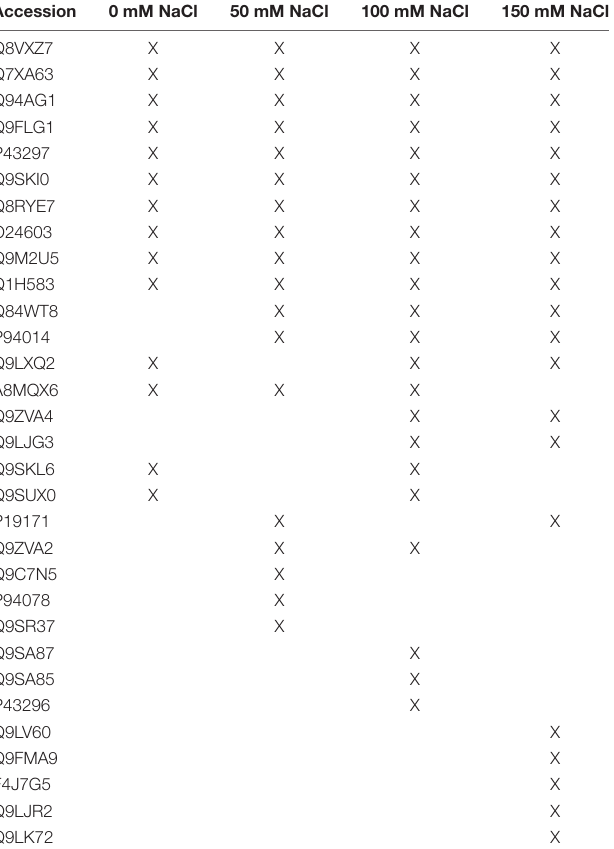
TABLE 1 | Secreted plant proteins in the presence of the fungus under the different salt concentrations.